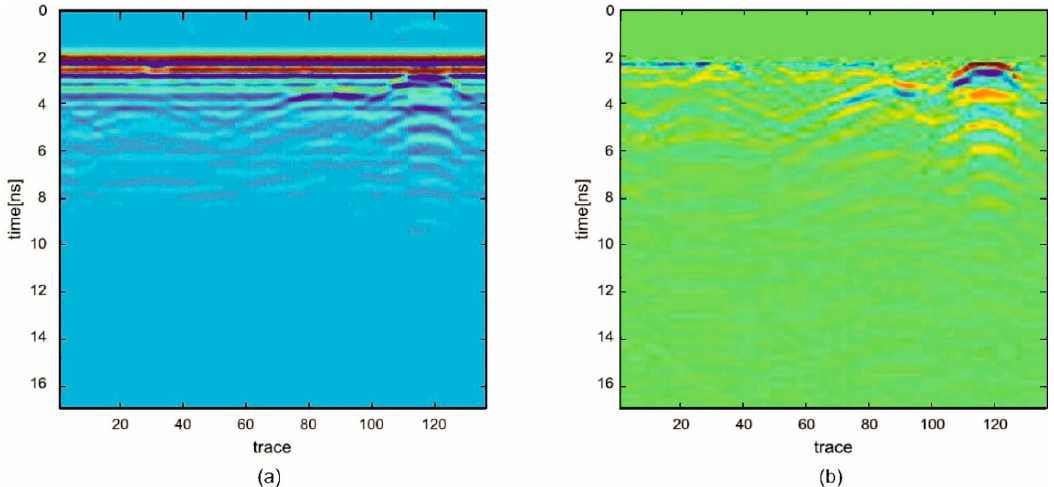
Figure 15. Radargrams of the real tree scenario. ( a ) Raw radargam; ( b ) processed radargram after the application of the pre-processing stage.